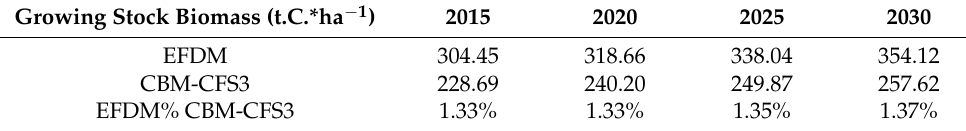
Table 5. Comparison of levels of growing stock biomass (t.C.*ha − 1 ).